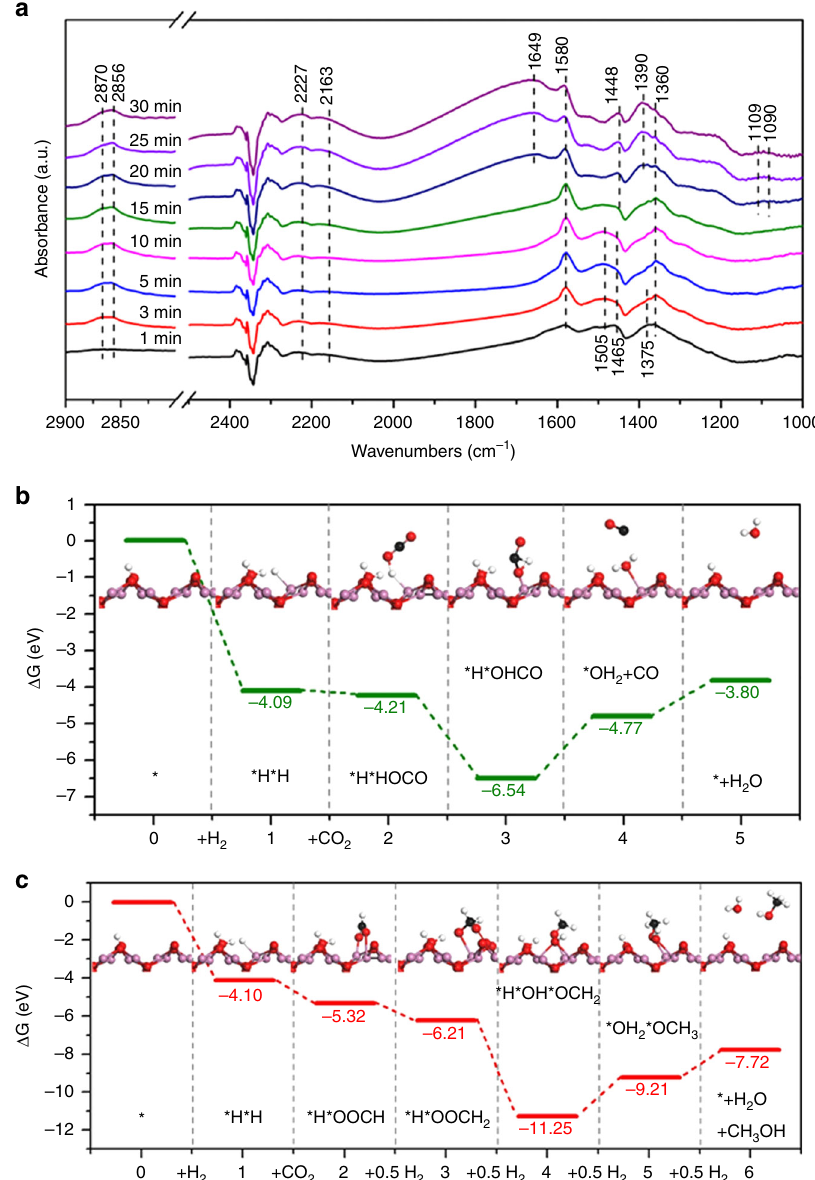
Fig. 5 CO 2 hydrogenation mechanism on rh-In 2 O 3-x (OH) y nanocrystals. a In situ DRIFTS spectra of surface species formed from CO 2 hydrogenation. b Energy pro fi les for CO 2 hydrogenation via the RWGS pathway. c Energy pro fi les for CO 2 hydrogenation via the formate pathway. Insets are the corresponding structures of reaction intermediates. The zero energy corresponds to the total free energy of the rh-In 2 O 3-x (OH) y